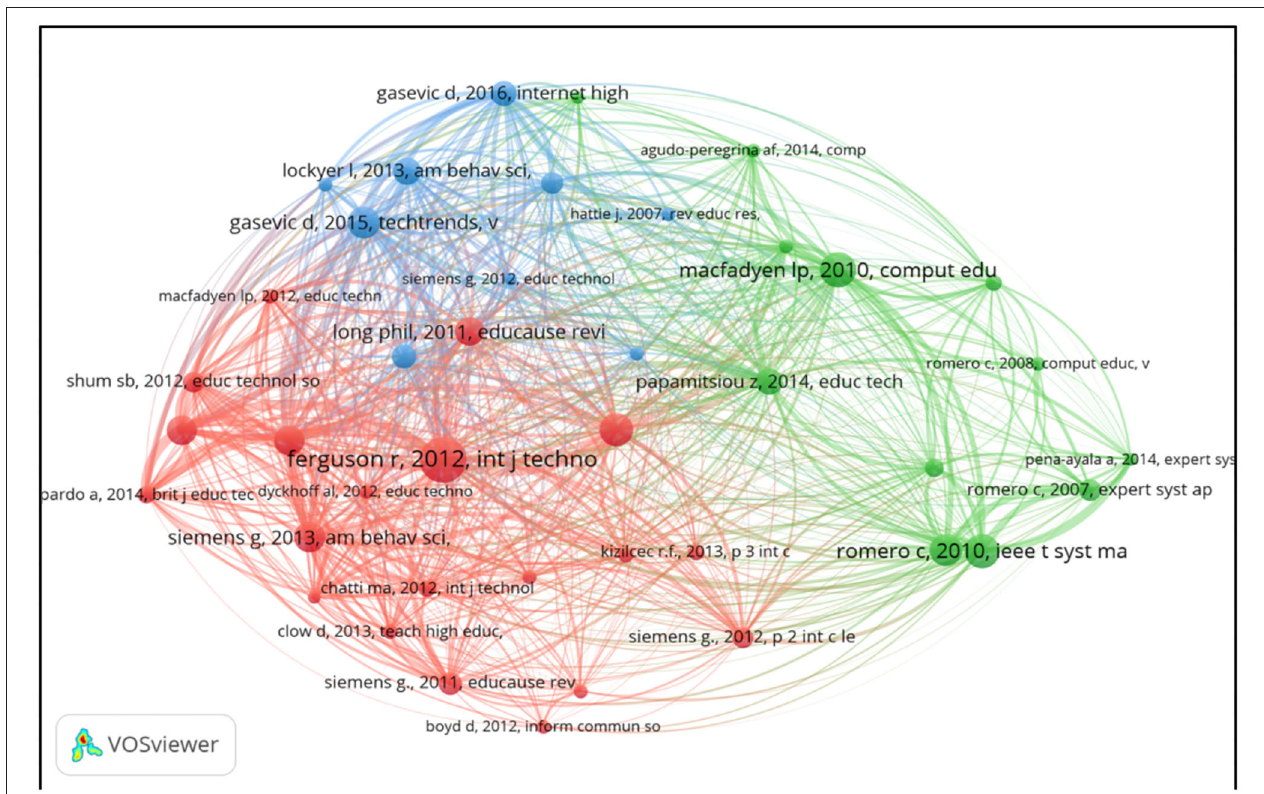
FIGURE 14 | Network visualization map of cited reference [items 41, links 762, total link strength 4,936].